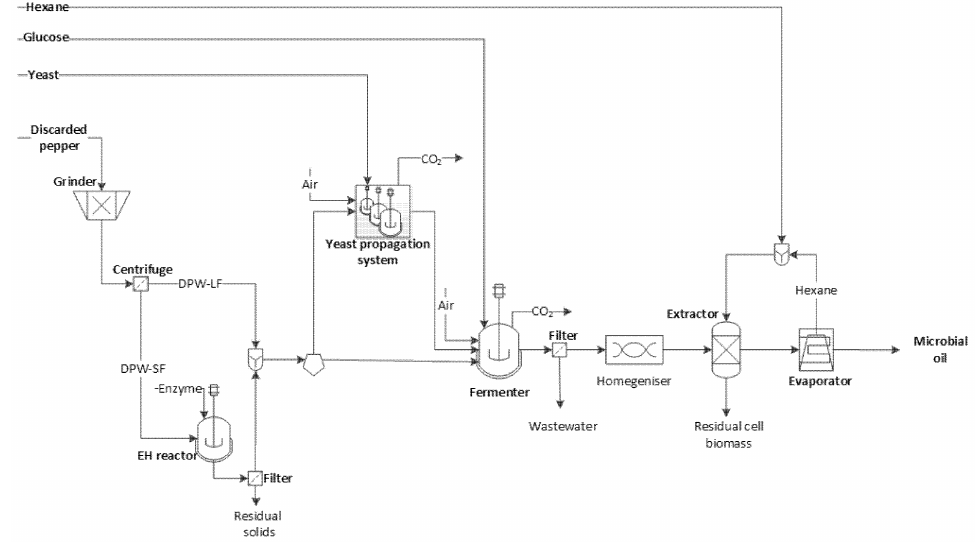
Figure 1. Simplified diagram of the microbial oil production plant based on discarded